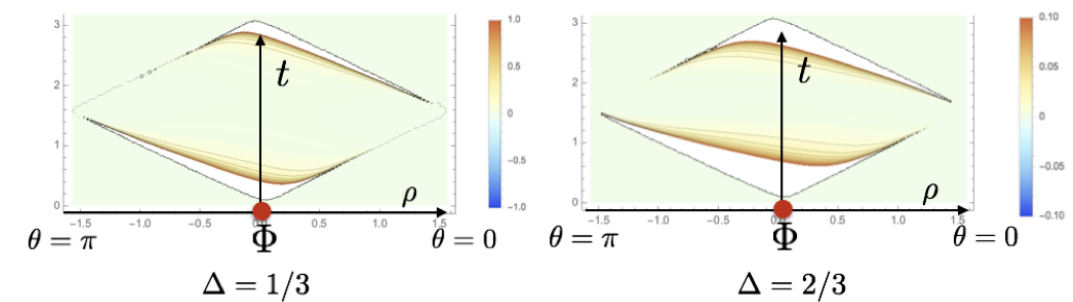
Figure 5 . Time evolution of null energy in the case when we introduce single trace deformation in the bulk, divided by g 2 . We can observe positive null energy is emitted from the point where we inserted single trace deformation. In particular, null energy is always positive